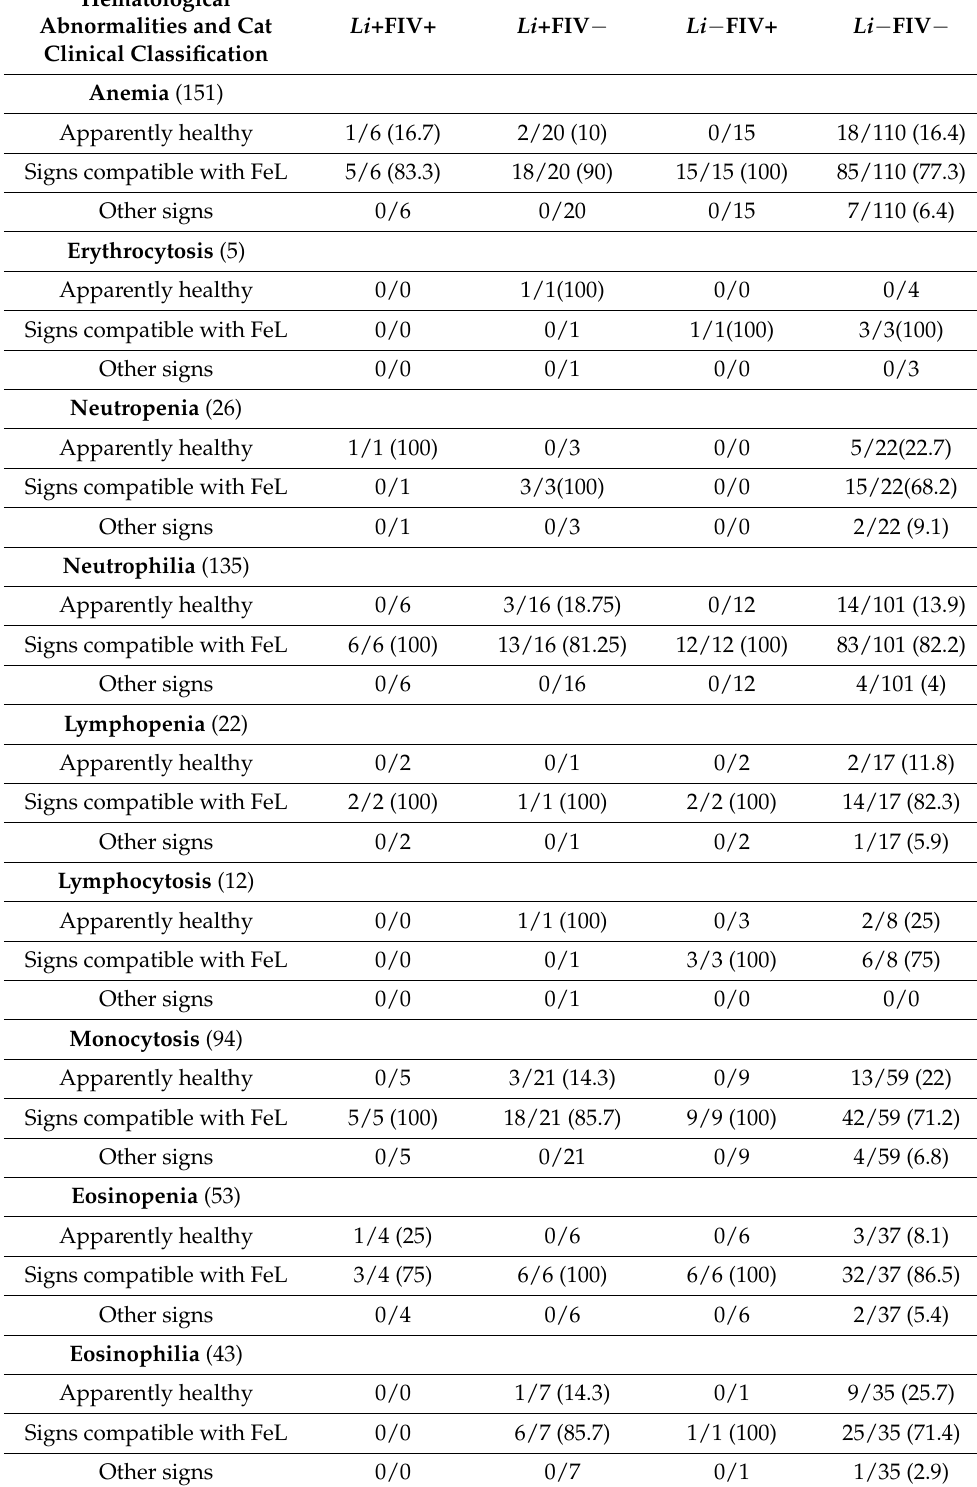
Table 10. Description of hematological abnormalities observed in total enrolled cats with number of cats ( n ) presenting each of them. The prevalence of each abnormality is reported ( n (%)) in cats classified according to their infection pattern ( Li +FIV+; Li +FIV − ; Li − FIV+; Li − FIV − ) and clinical status (apparently healthy, signs compatible with FeL, different/other